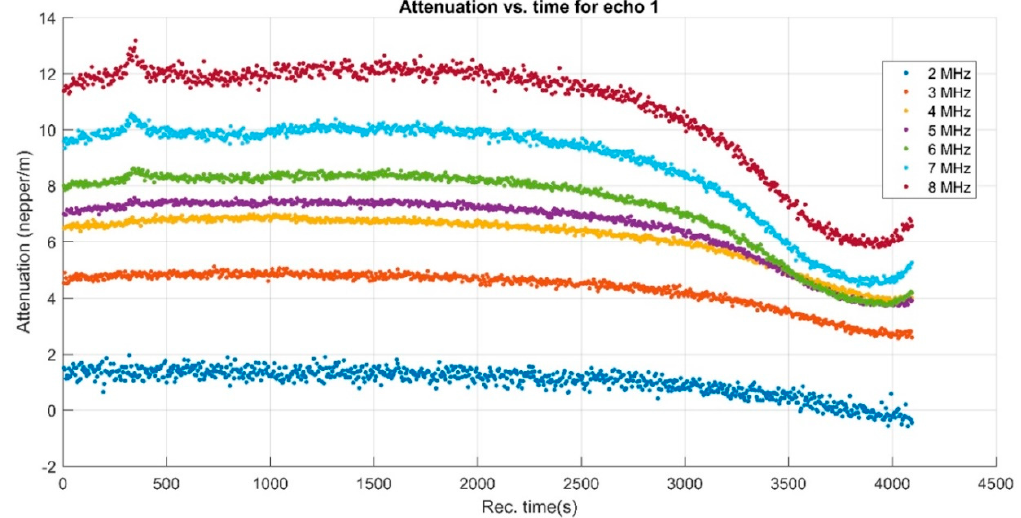
Figure 6. Attenuation vs. time for the spectral components of echo 1.